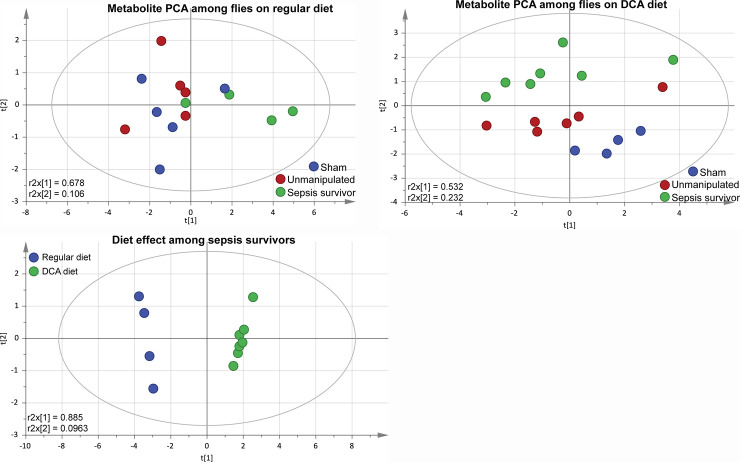
Multivariate analysis of metabolomic LC-MS data show DCA-dependent changes among sepsis survivors.We studied changes in metabolite levels in sham and sepsis survivors with or without DCA treatment. We used the unmanipulated flies to normalize metabolite concentrations in sham and sepsis survivor groups. (A) Multivariate analysis with unsupervised PCA model showed that flies on regular diet could not be separated according to their group (r2x = 0.678) (Fig 5A). (B) However, when flies were treated with DCA, PCA score plot shows that the 2 first components could discriminate sham from unmanipulated and sepsis survivors (r2x = 0.532) (Fig 5B). (C) Finally, when we compared the effects of DCA among the sepsis survivors, the PCA model could clearly discriminate two clusters along the first component (r2x = 0.885) (Fig 5C). The metabolites having the highest weight on the first component were α-ketoglutarate, fumarate, and pyruvate. The number of biological repeats for LC-MS was n = 5.